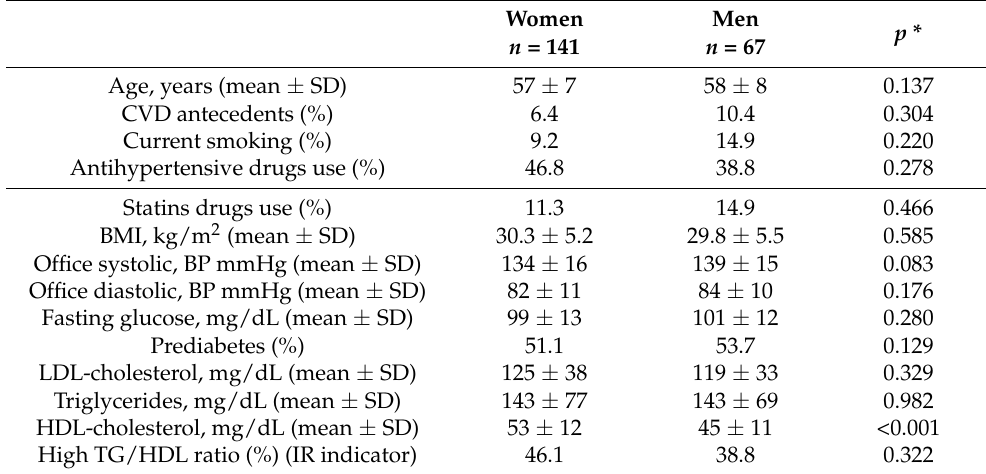
Table 1. Clinical, metabolic, and therapeutic characteristics of the cohort according to gender.